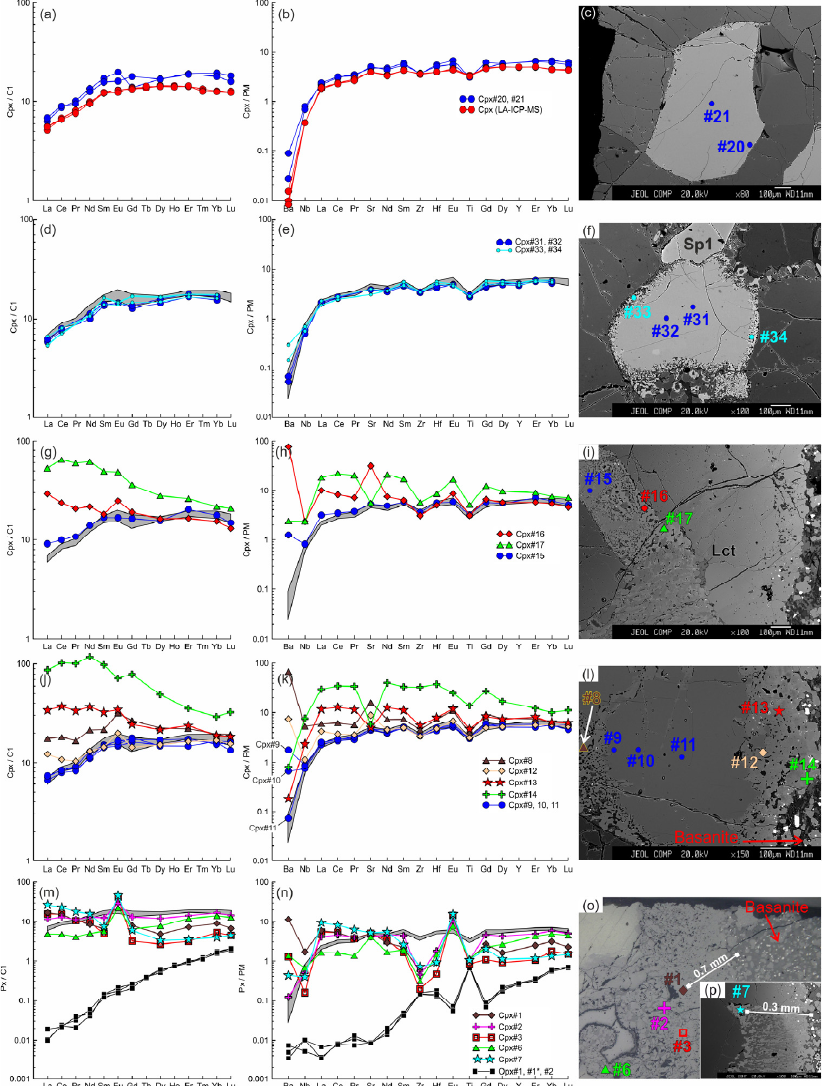
Figure 8. The trace element composition of the clino- and orthopyroxenes from sample HD38 normalized to the CI chondrite [31] ( a , d , g , j , m ) and primitive mantle [31] ( b , e , h , k , n ). ( a – c ) Primary clinopyroxene (#20, #21) without reaction zones. Trace element composition of primary clinopyroxene obtained by LA ‐ ICP ‐ MS is shown for comparison. ( d – f ) Cpx1 (#31, #32) with thin reaction zone of Cpx2 (#33, #34). In ( d , e , g , h , j , k , m , n ), the gray field shows the compositions of the primary clinopyroxene (#20, #21). ( g – i ) Cpx1 (Cpx#15) with a wide reaction zone of Cpx2 (Cpx#16, Cpx#17) near the basanite/xenolith contact. ( j – l ) Cpx1 (#9–11) with a wide reaction zone of Cpx2 (#12–14) at basanite/xenolith contact. ( m – p ) Cpx3 (#1–7) from the orthopyroxene reaction zone at basanite/xenolith contact. The location of the primary orthopyroxene (#1, #1*, #2) is beyond the sample areas shown on the photo.